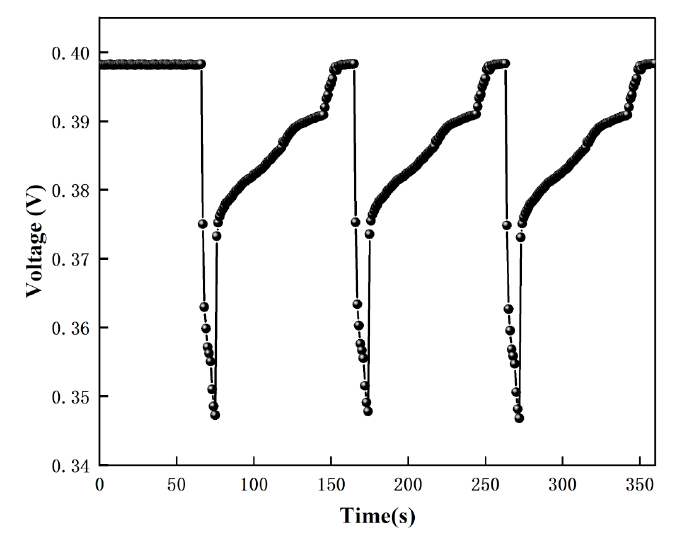
Figure 24. The test results of